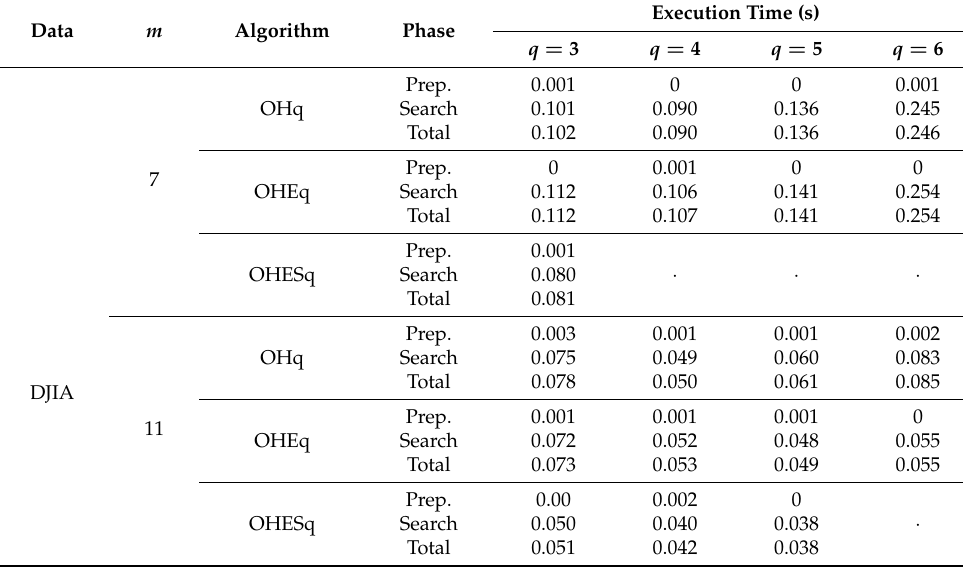
Table A3. Execution times of 1000 patterns for DJIA